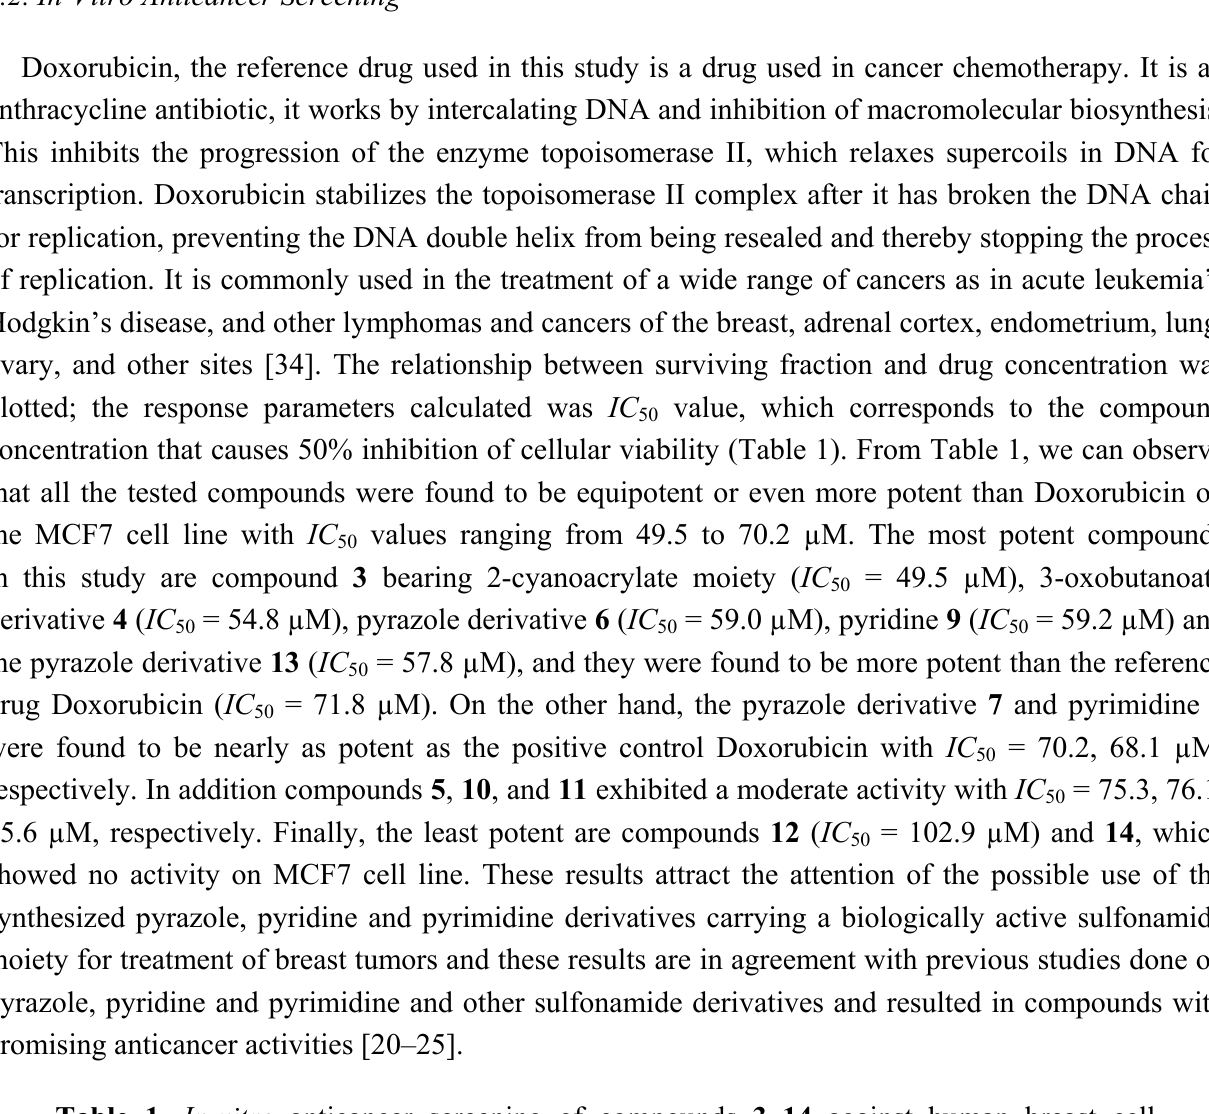
Table 1. In-vitro anticancer screening of compounds 3 – 14 against human breast cell line